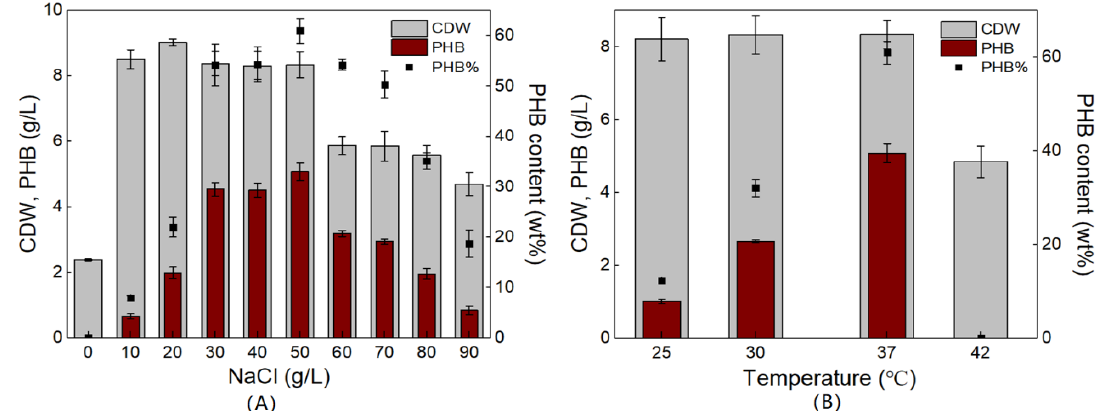
Figure 5. CDW, PHB concentration, and PHB content profiles of V. alginolyticus LHF01 cultivated in TYS medium supple- mented with 20 g/L glycerol at different NaCl concentrations ( A ) and temperatures ( B ). Data are expressed as averages and standard deviations of three parallel